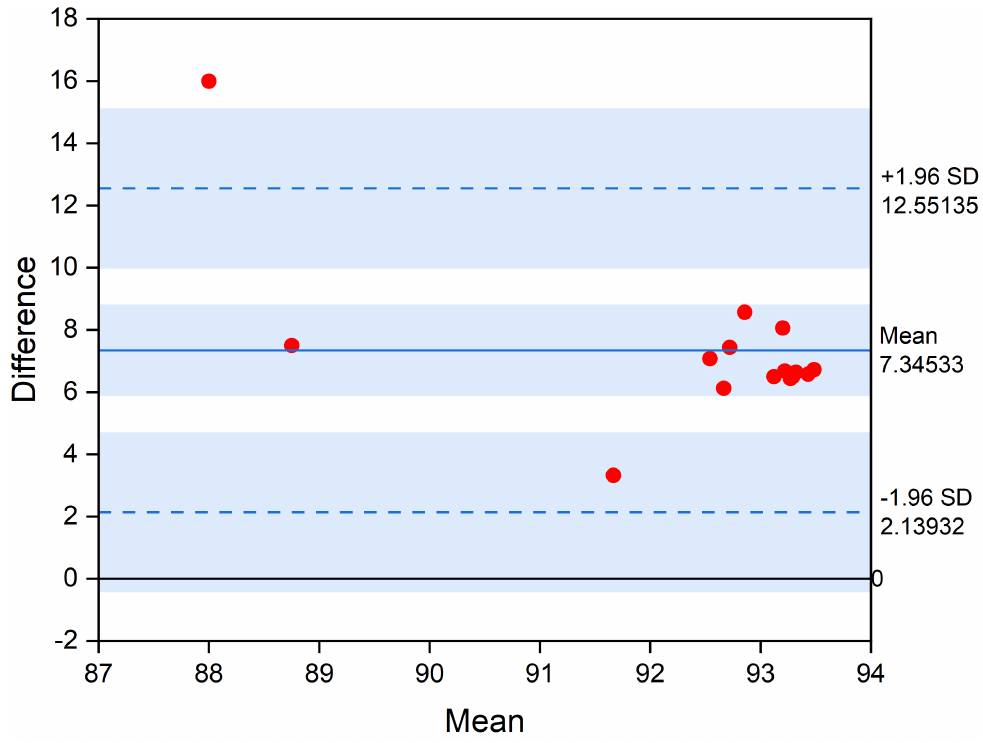
Altman plot comparing the accuracy of different SNN solutions against the baseline Figure 13. Bland − 1DCNN